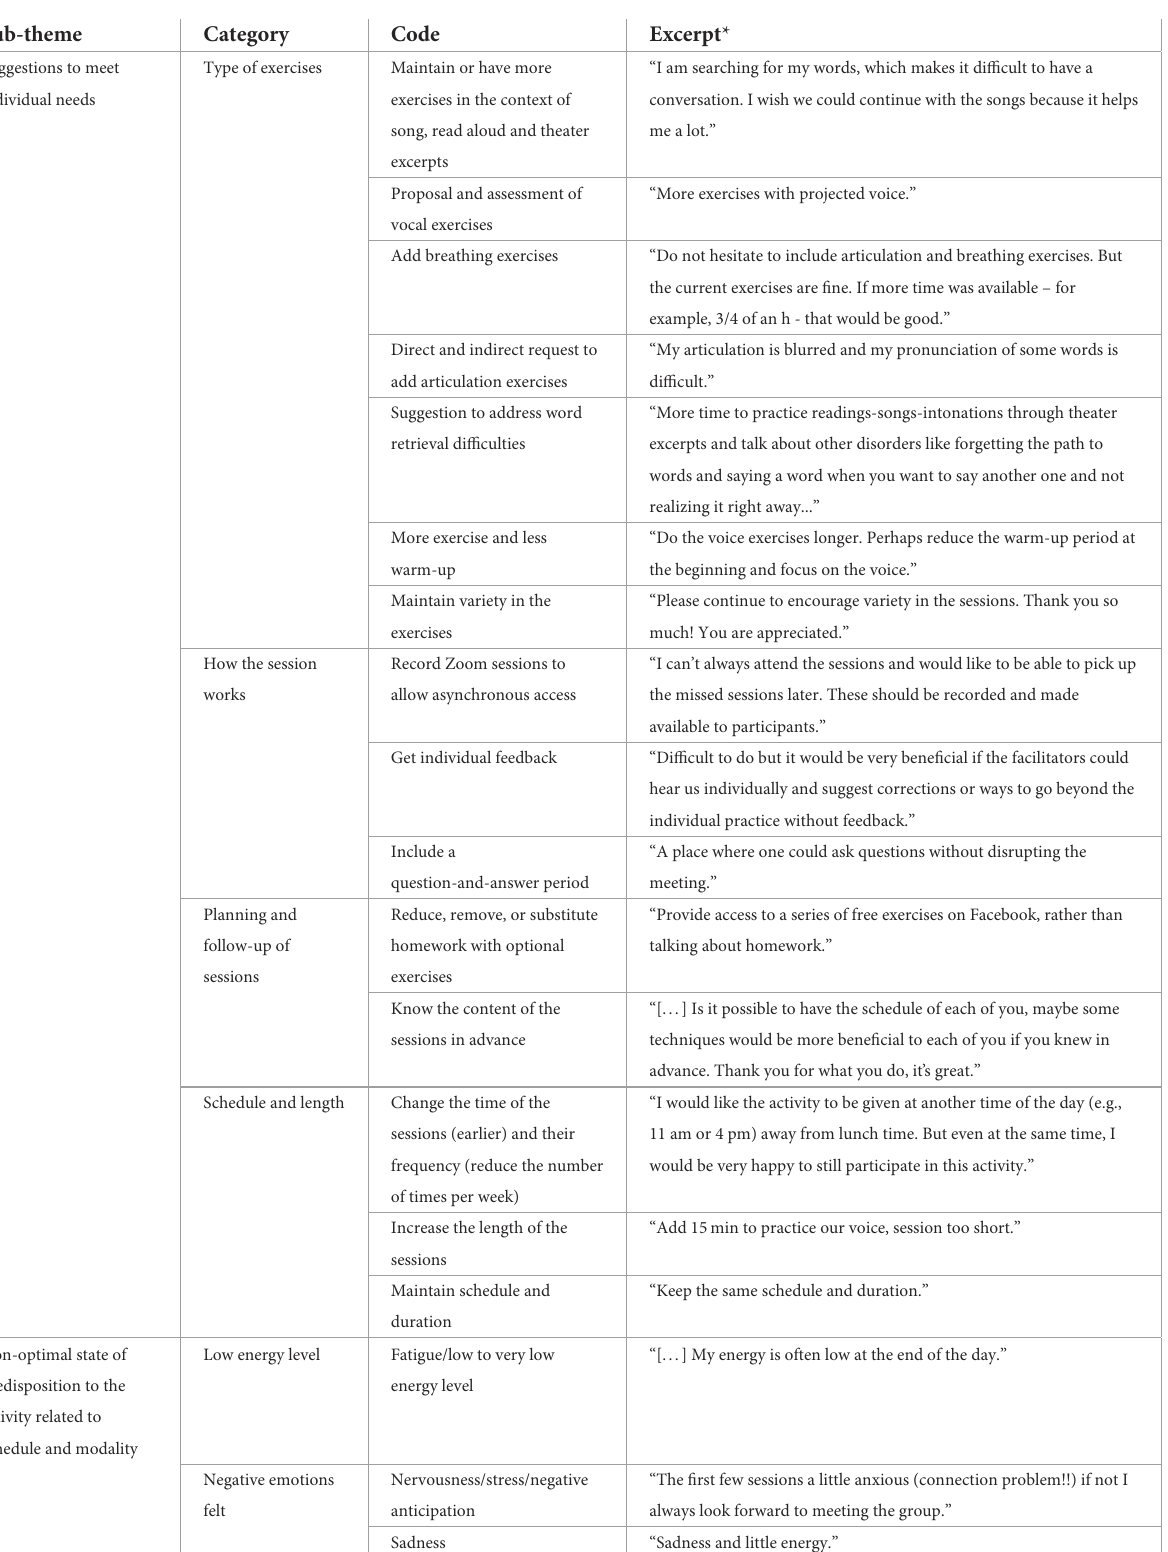
TABLE 5 Perceived limitations of MdlV and persisting